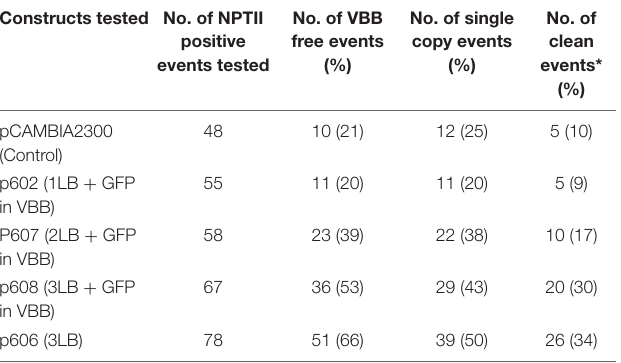
TABLE 2 | Frequency of VBB free, single T-DNA copy in transgenic cassava plants.